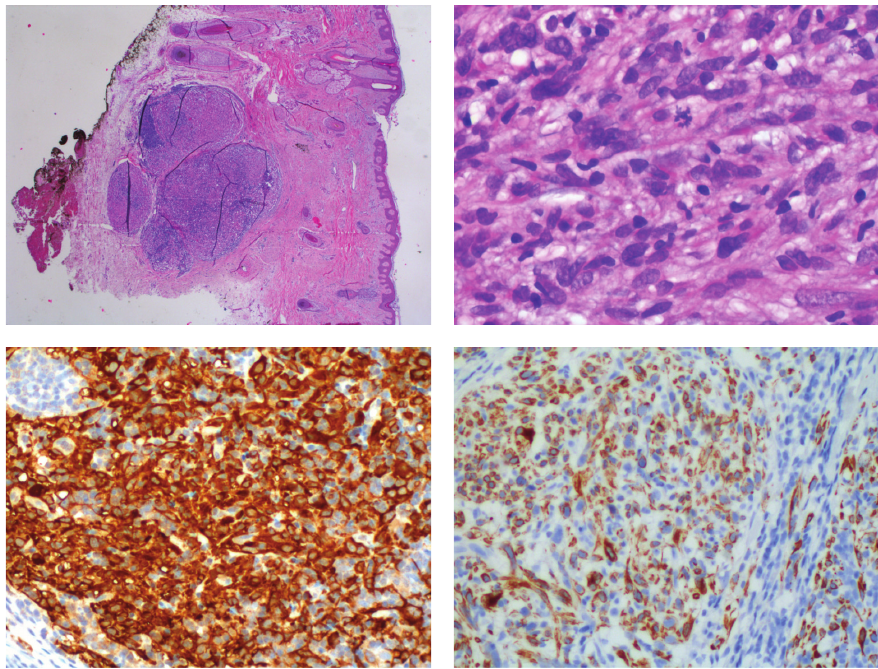
Figure 1: Tumor cells from scalp stained with hematoxylin-eosin, caldesmon, and